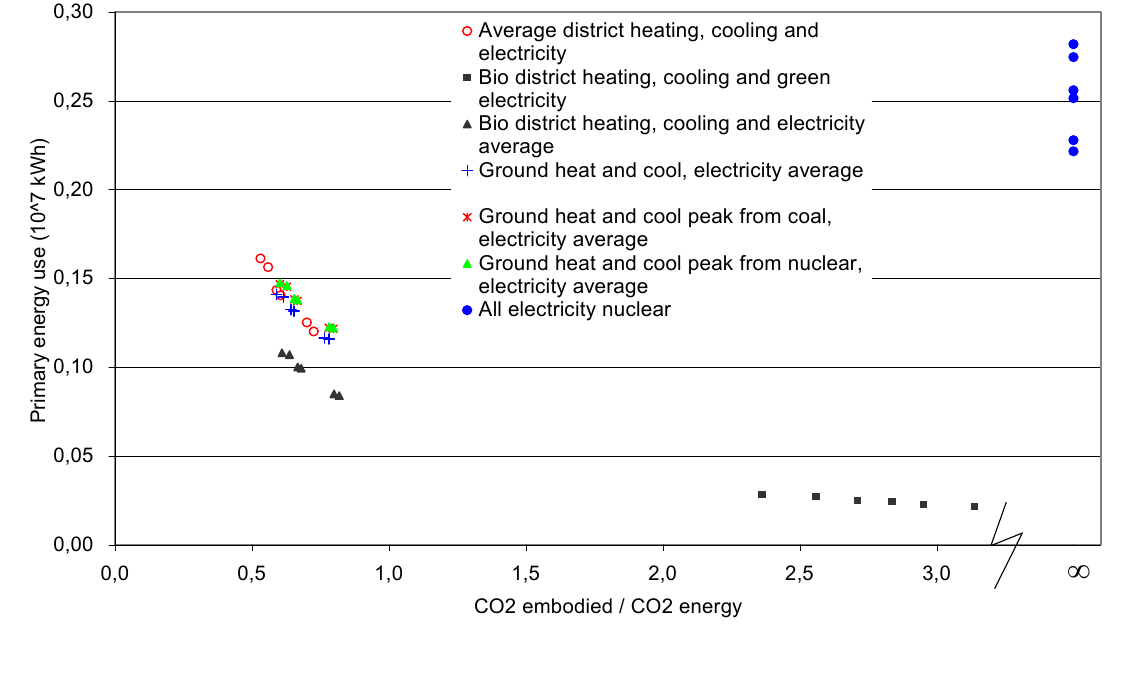
Figure 5. Primary energy consumption as a function of the relation between embodied and equivalent emissions. The CO energy derivated CO 2 CO emissions from materials during their life time and CO 2 CO emissions from energy use in the building (heating, cooling and electricity). The time 2 period used in calculations is 50